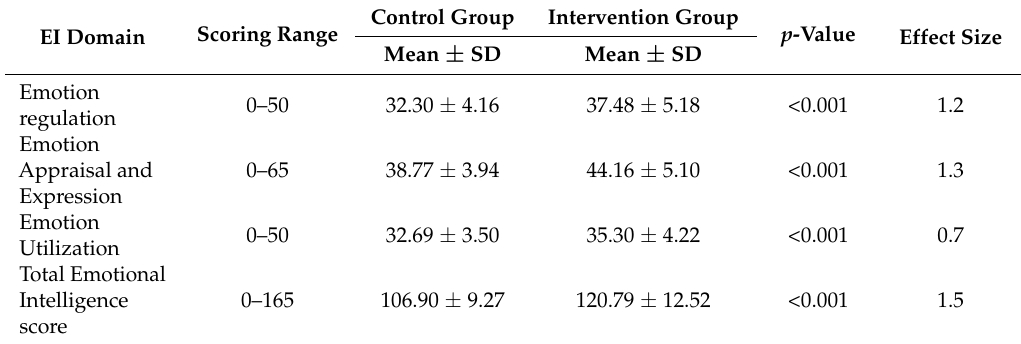
Table 2. Emotional Intelligence comparison between intervention and control group (6 weeks after the day 1) just after the intervention.